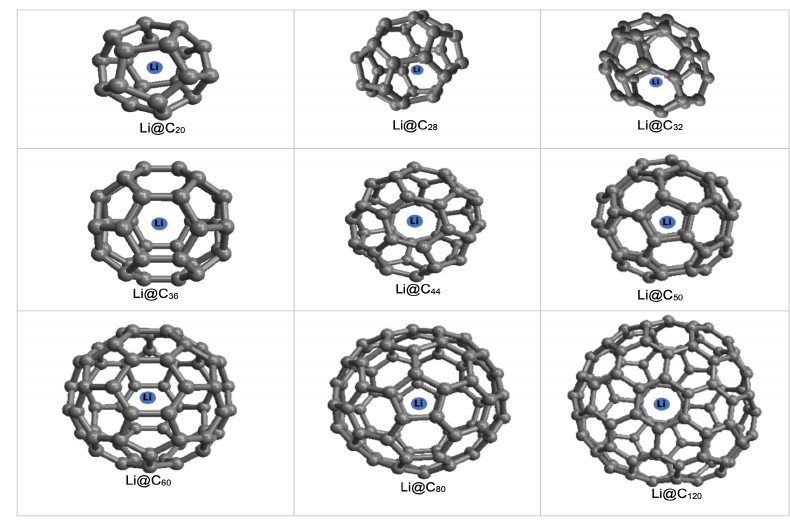
Figure 1. Storage of a Li atom in C N